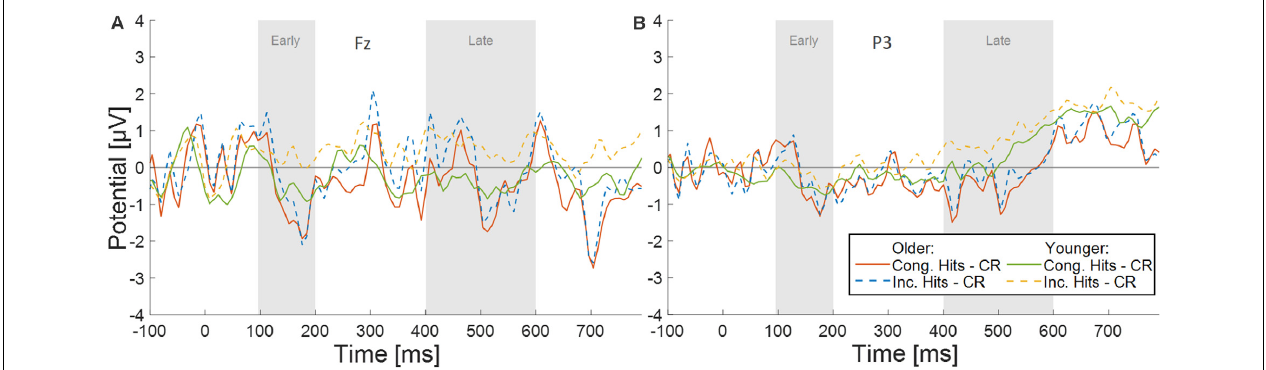
FIGURE 4 | Difference waves for both conditions (Congruent Hits minus Correct Rejection, and Incongruent Hits minus Correct Rejection) for both age groups (Younger and Older participants) for electrodes (A) Fz, and (B) P3.